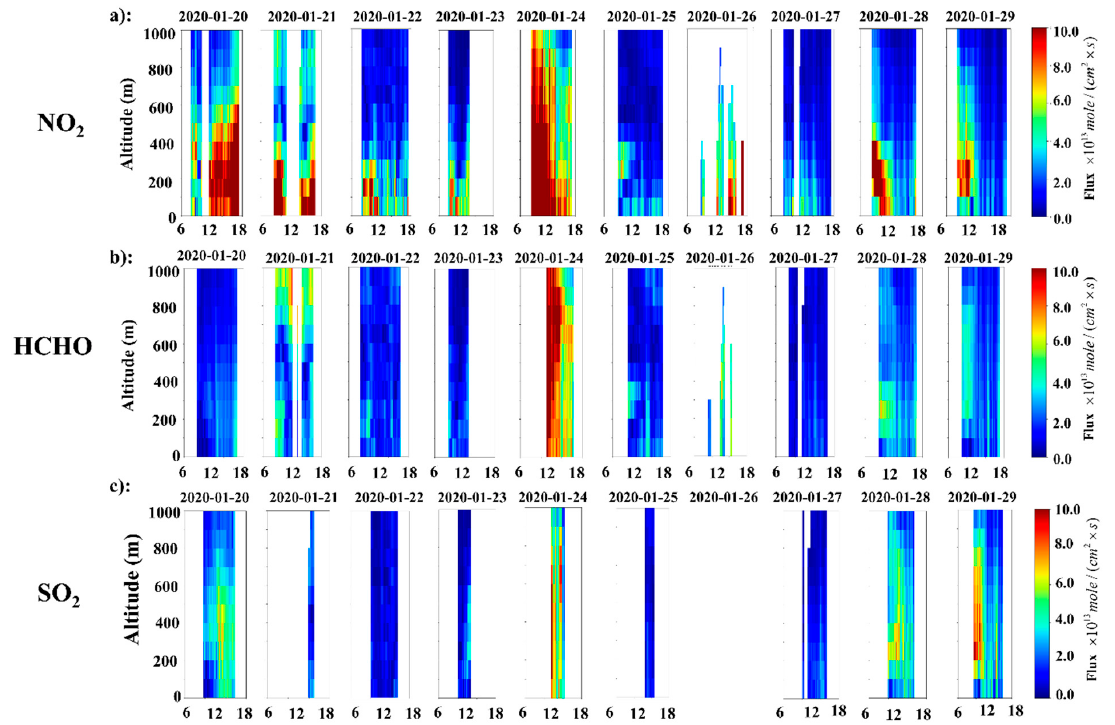
Figure 10. Horizontal transport flux profiles, ( a ) for NO 2 , ( b ) for HCHO and ( c ) for SO 2 , in Luoyang from 20 January 2020